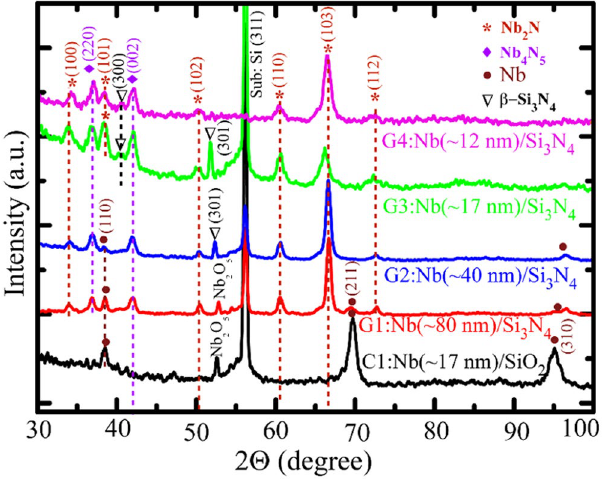
Figure 2. XRD characterization. A set of XRD spectra for 4 nitride samples varying in thickness and one control sample of Nb film on SiO 2 /Si substrate. With decreasing thickness for the nitride substrates, elemental Nb phase disappears and Nb 2 N phase starts to dominate. The samples G3 and G4 are the reference samples grown simultaneously with B1 and B2, respectively, where B1 and B2 have been used to study the transport characteristics presented in the subsequent section.